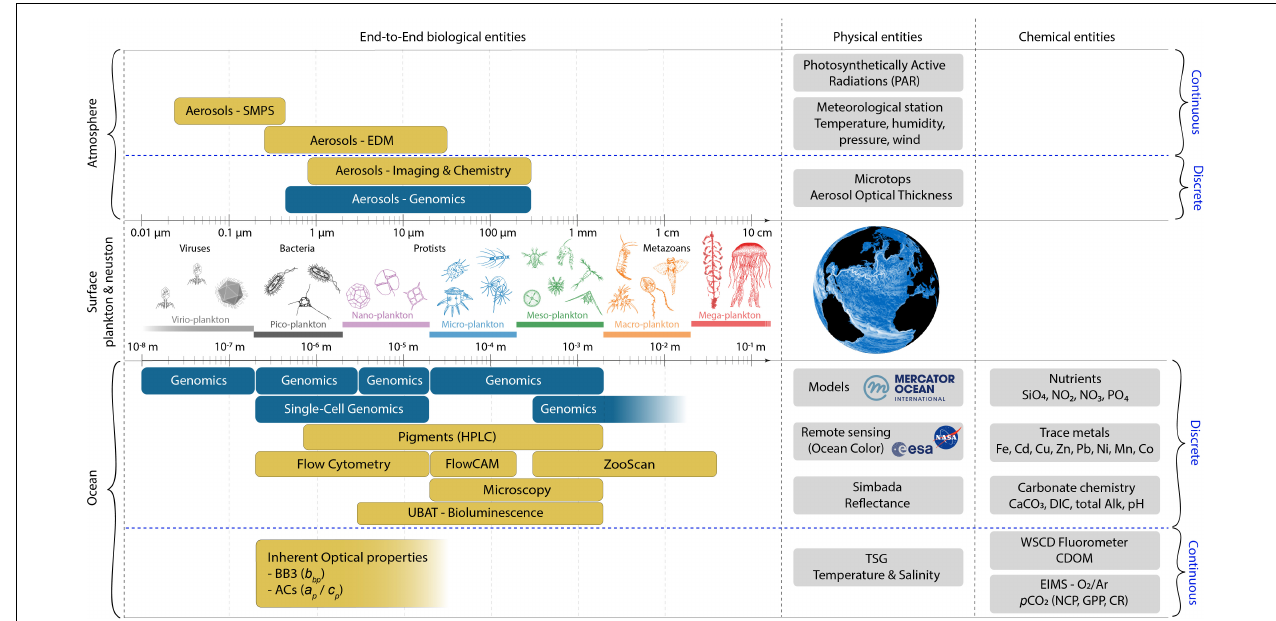
FIGURE 9 | Schematic summary of the systems approach and “end-to-end” plankton sampling adopted during the Tara Pacific expedition. The size spectrum and classification of entities that characterize the ocean-atmosphere interface are depicted in the left section . The various devices and protocols used to sample the atmosphere (top section) and the ocean surface (bottom section) are shown, indicating which, biological physical or chemical entities are targeted by each